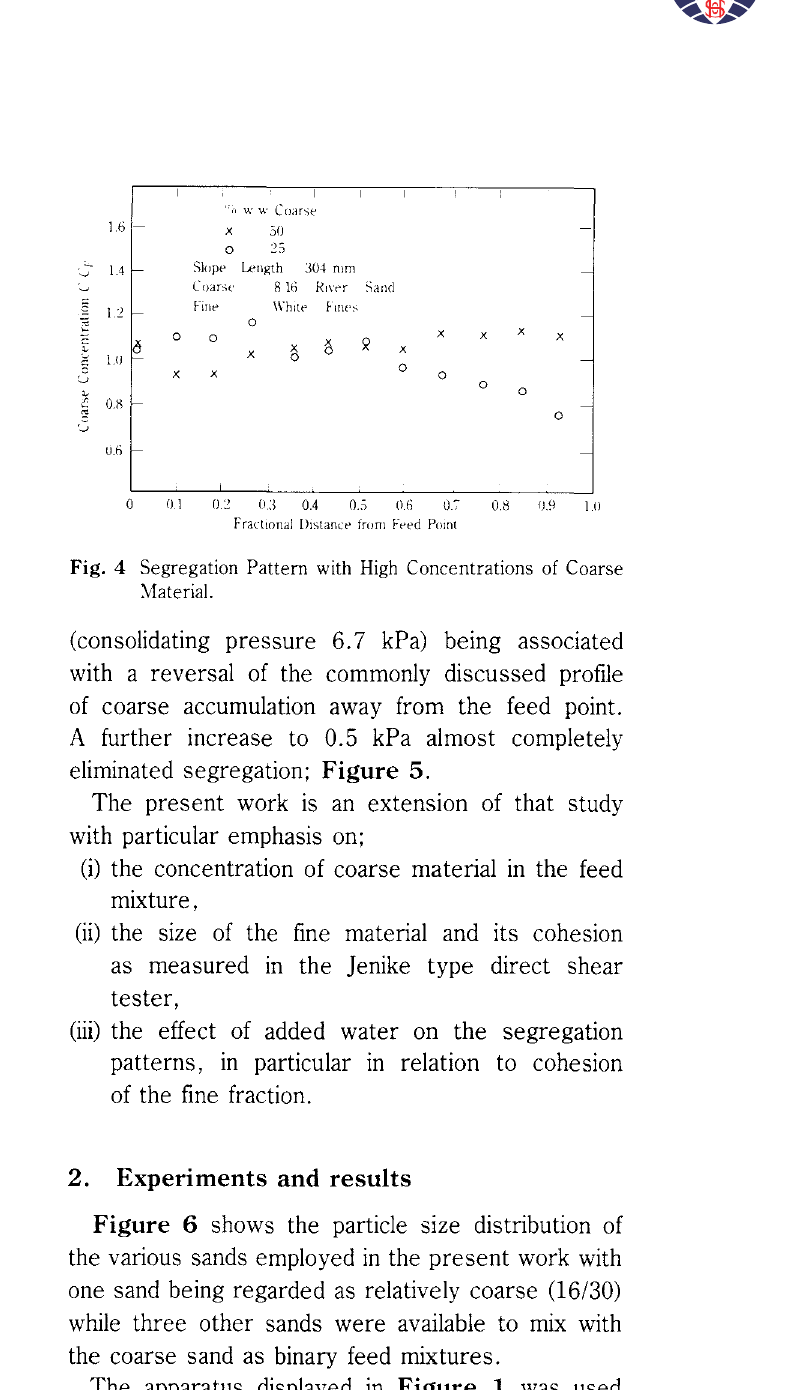
Fig. 2 Segregation Patterns with Relatively Coarse Fines.